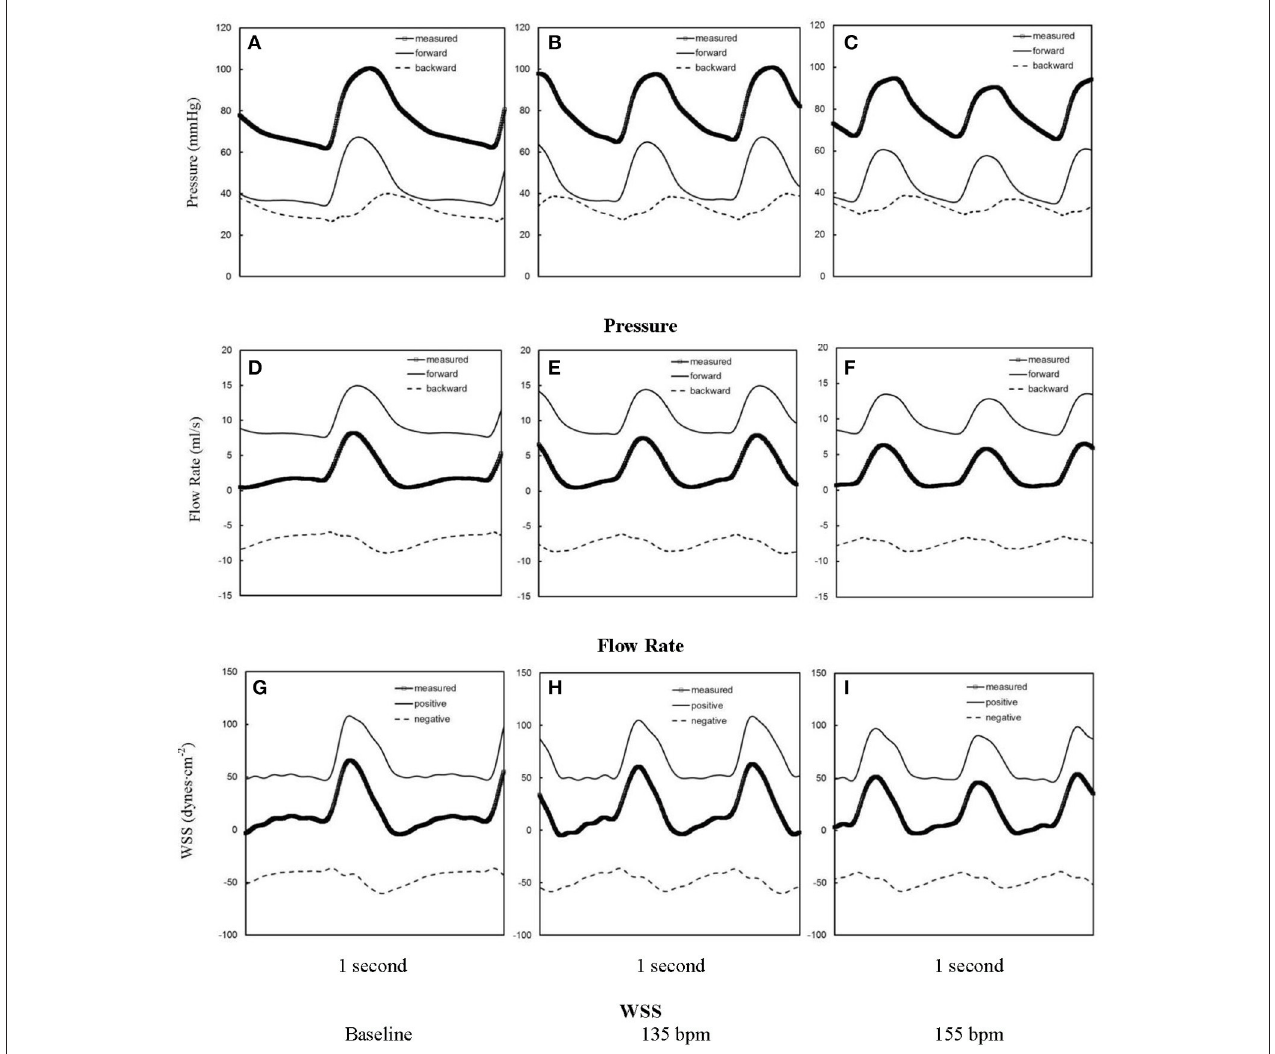
FIGURE 2 | Pressure waves in femoral artery (A) at baseline and after the heart rate was paced to (B) 135 bpm and (C) 155 bpm. (D–F,G–I) refer to flow and WSS waves, respectively, in femoral artery corresponding to (A–C) . The marked, solid, and dash lines represent the measured, forward, and backward waves, respectively.